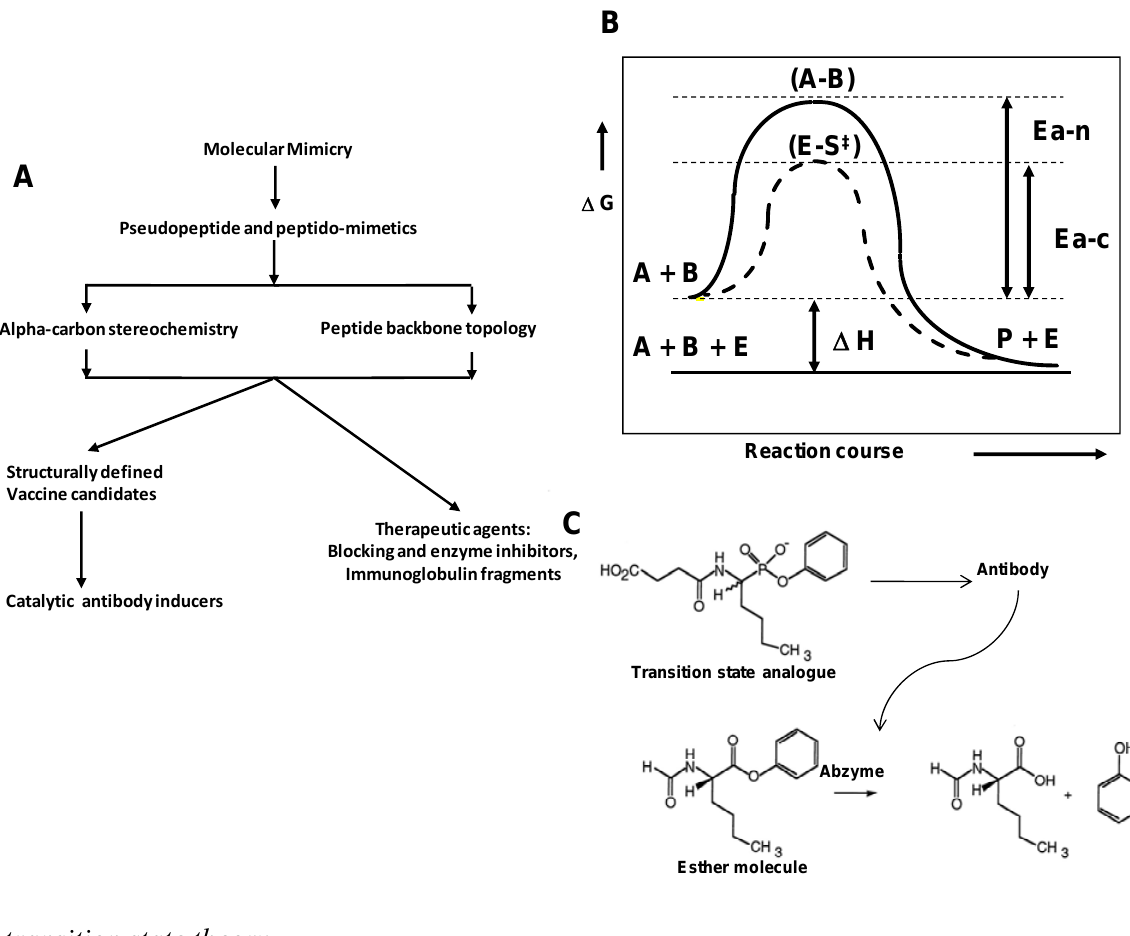
Figure 1. Development of pseudopeptide chemistry. A. Applications of pseudopeptide and peptido-mimetics in drug and vaccine discovery. B. Energetic profile for a given chemical reaction, being non-catalyzed and processed by a biological catalyst. C. Ester hydrolysis reaction catalyzed by antibody 17E8 and structure of the phosphonate transition-state analog used to elicit this antibody as discussed